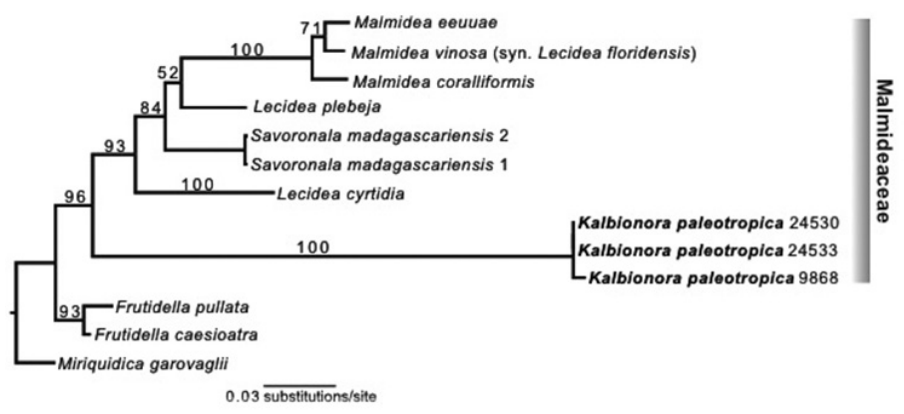
Figure 2. Phylogenetic tree depicting the relationship of Kalbionora palaeotropica in Malmideaceae based on mtSSU and nuLSU rDNA sequences. Bootstrap support values above 50% are displayed at